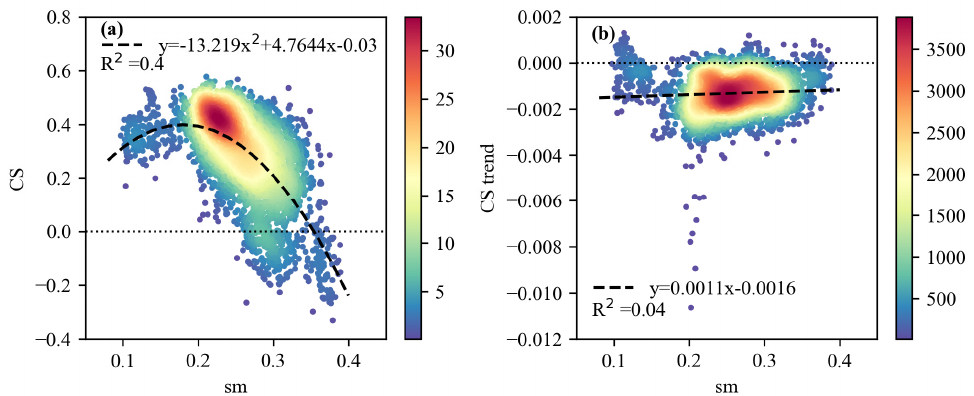
Figure 9. ( a ) Variation in evapotranspiration–precipitation CS and ( b ) its trend with soil moisture (shades of color indicate the density of the points).